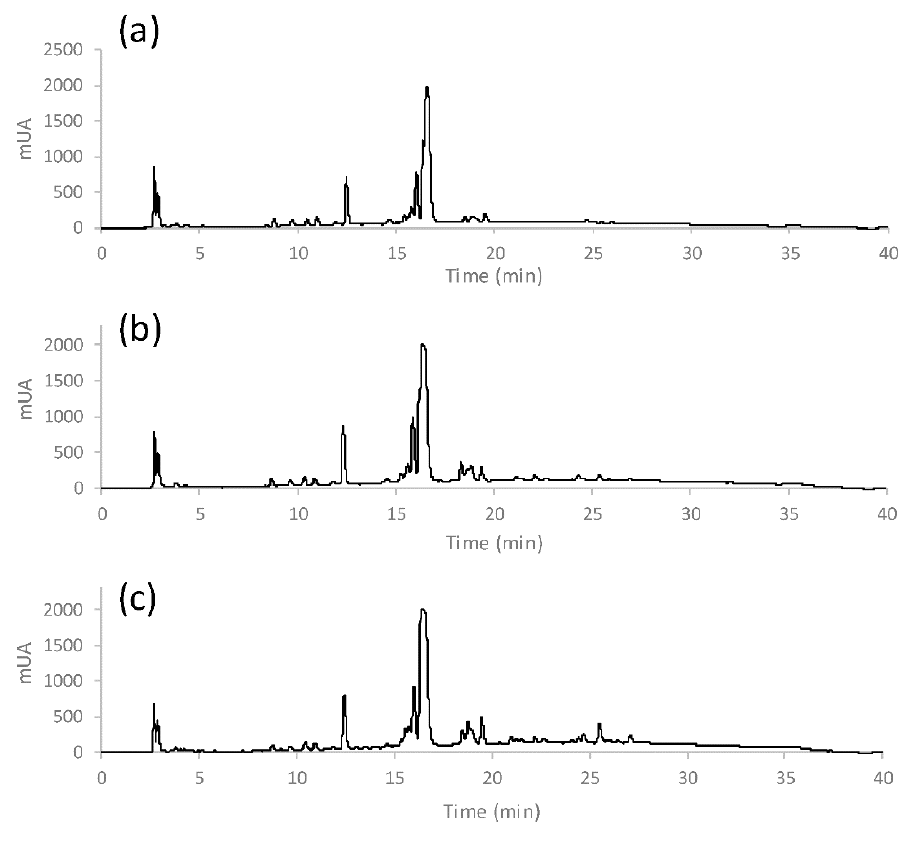
Figure 7. Non-targeted HPLC-UV/VIS fingerprints of Arabica coffee from Ethiopia ( a ), Arabica-Robusta mixture from India ( b ), and Robusta coffee from Uganda ( c ) [1].